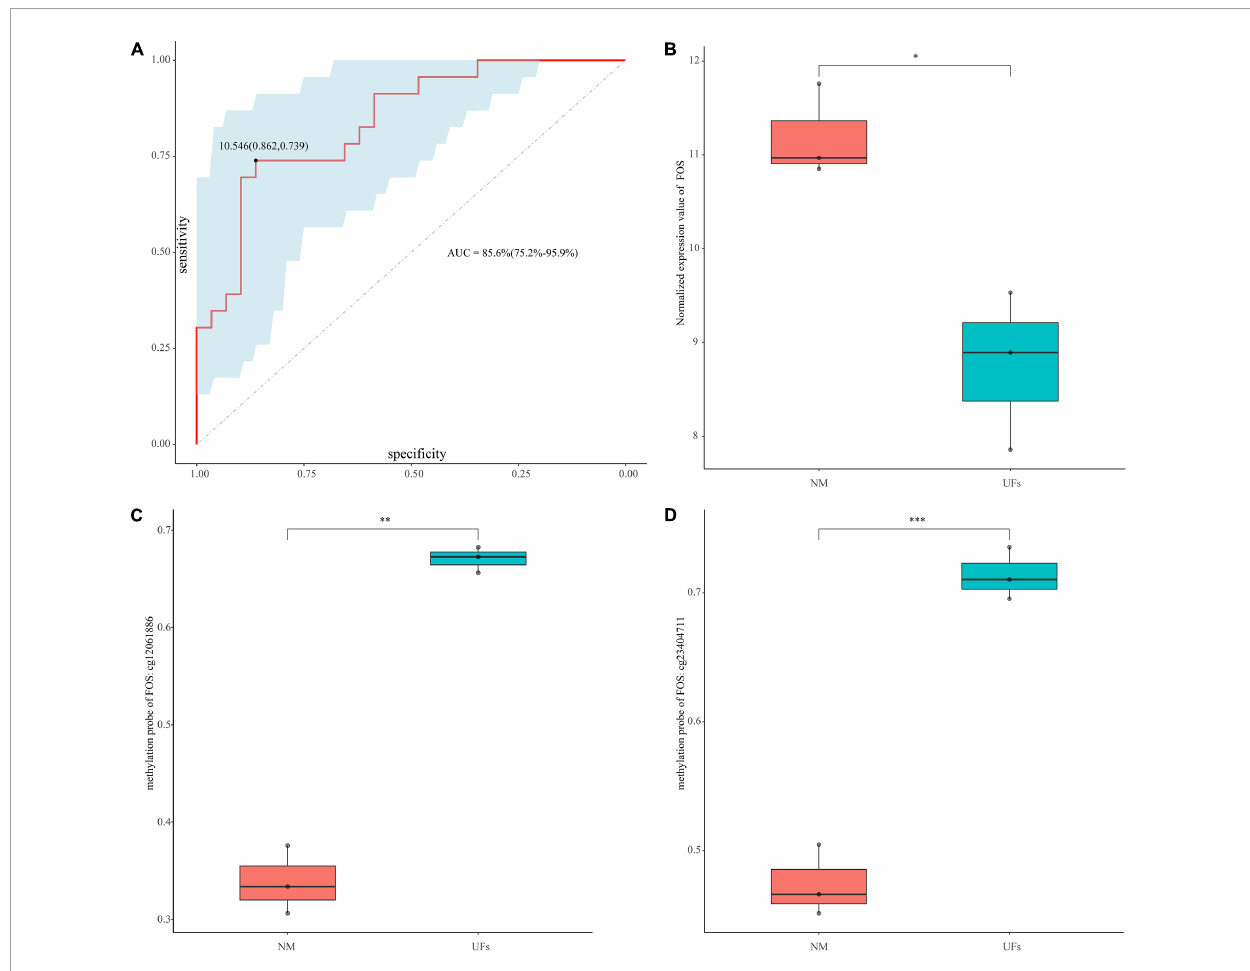
FIGURE6 Diagnostic value of FOS. (A) ROC curve analysis and area under curve (AUC) of FOS. (B) GSE45188 supported the low expression of FOS in the fibroid samples. (C,D) The methylation level of the two differential methylation probes of FOS in GSE45188. ∗ P < 0.05, ∗∗ P < 0.01, and ∗∗∗ P <